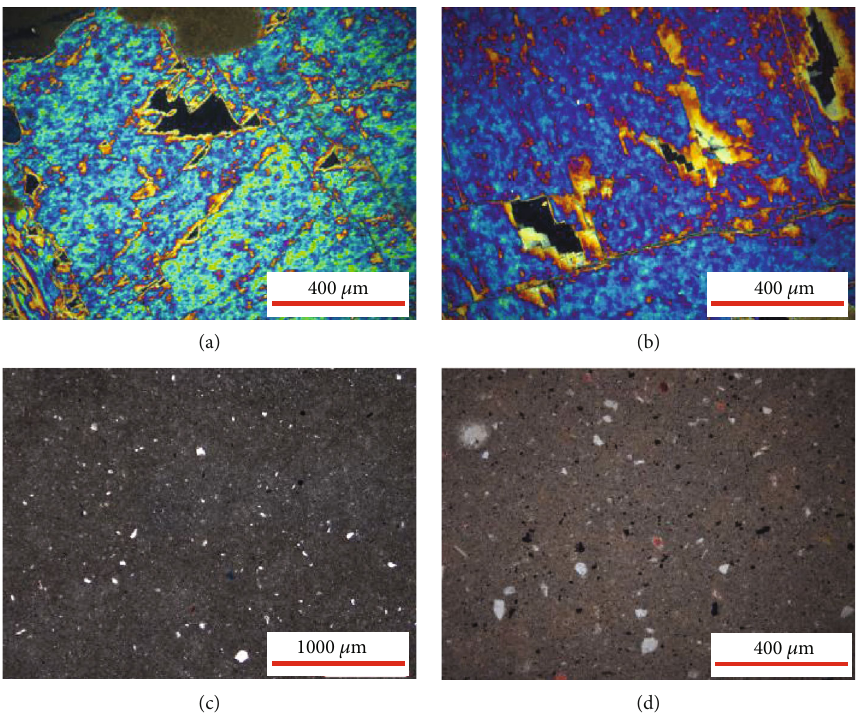
Figure 3: Microscopic observation of the Palaeogene Xiaganchaigou Formation samples from Qaidam Basin. Massive development of gypsum cements and remaining of numerous microscale dissolution pores: (a) 4312.14 m and (b) 4317.26m. Mixed sendimentation of micrite or microcrystal dolomite and siliceous clastic particles: (c) 3864.81m and (d)